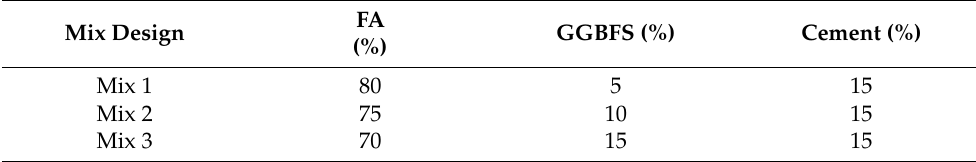
Table 2. Mix design used for cold-bonding granulation.